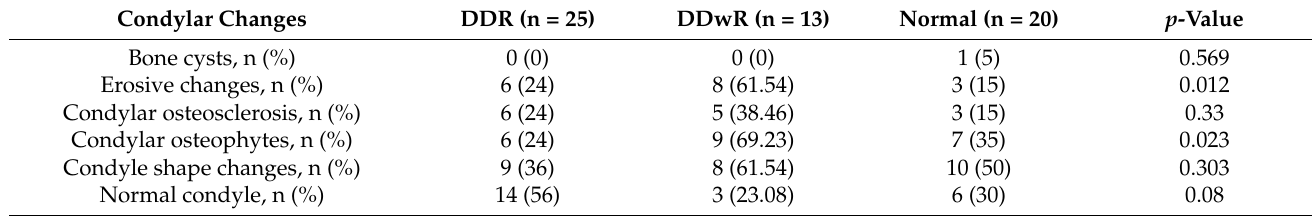
Table 5. Condylar changes in TMD according to disc position.